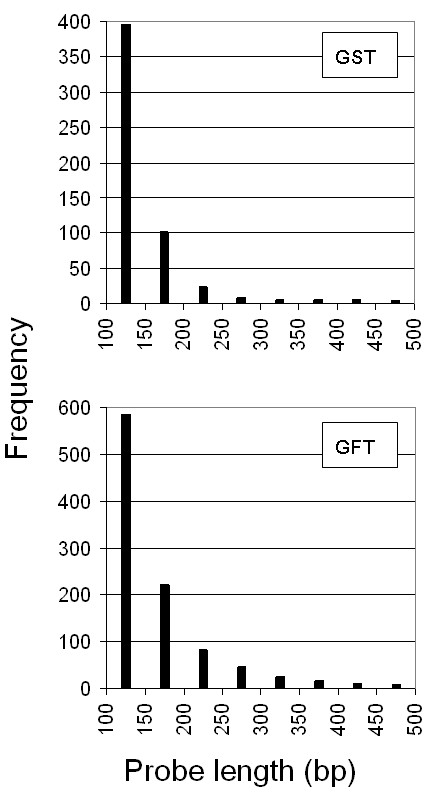
Distribution of probe length for both GSTs and GFTs. The distribution of the probe length is shown for all CATMAv4 addition features. The height of each bar corresponds to the number of probes in the length bins. Upper and lower panels represent the length distribution of the GFTs and GSTs, respectively.